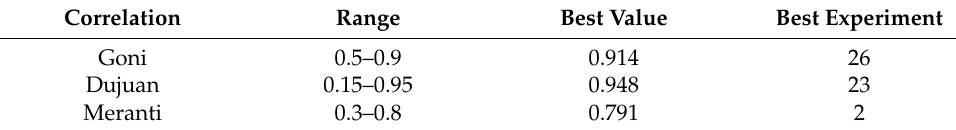
Table 9. R statistics of the wind direction simulation in the three typhoon events. Correlation